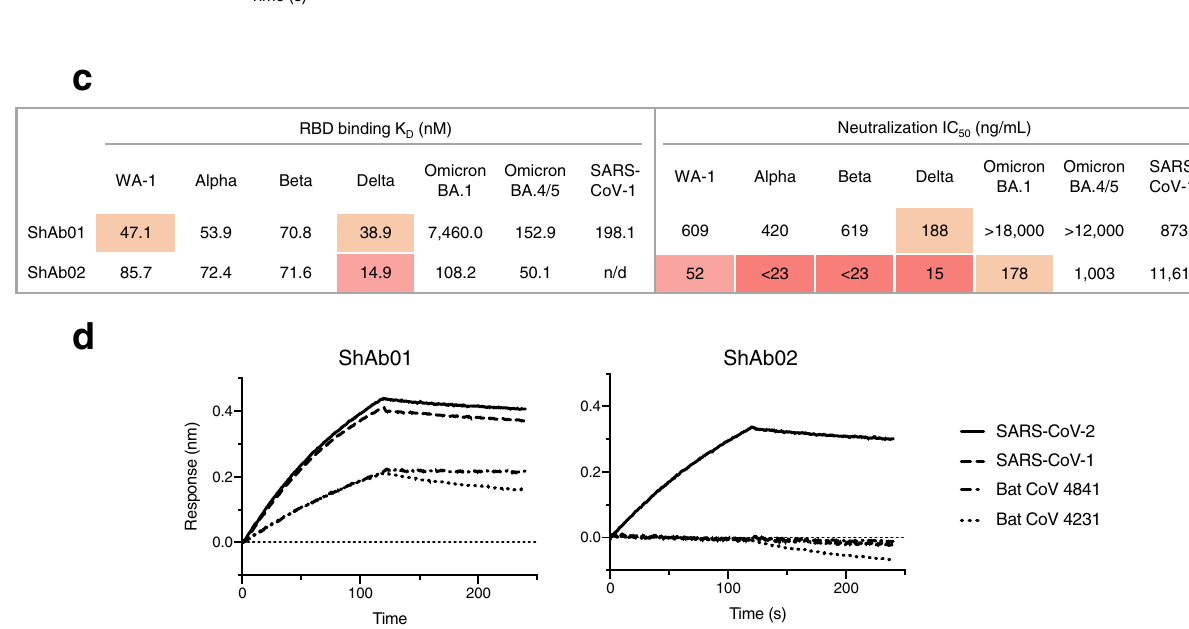
Fig. 2 | Antigenic characterization of the ShAb molecules. a ShAb RBD- competition assay assessed by Bio-Layer Interferometry (BLI). BLI measurements are performed with immobilized SARS-CoV-2 RBD and ShAb in solution. ShAb01 (top) or ShAb02 (bottom) are bound to the RBD molecule followed by incubation withotherShAbs. b EpitopebinningoftheShAbmolecules.Valuesrepresentthe% residual binding of the indicated second molecule (ShAb01, ShAb02, ACE2, or CR3022)aftersaturationoftheantigen(WA-1RBD)withtheindicated fi rstantibody (left column). Shading from dark to light indicates competition strength ranging